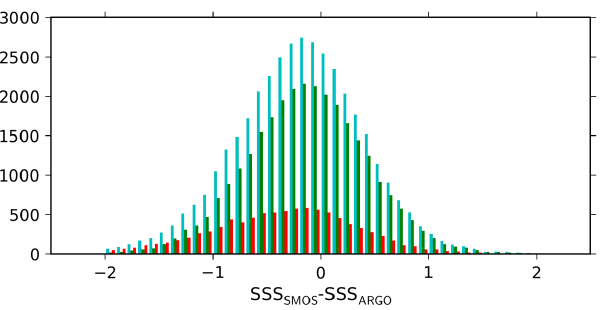
Fig. 6. Statistical distribution of SMOS SSS minus ARGO SSS in the tropical Pacific Ocean for various sortings on SSM/I rain rates; blue: all collocations (without any rain sorting); green: non- rainy cases (SSM/I rain rates less than 0.1mmh − 1 ) ; red: rainy cases (SSM/I rain rates larger than 0.1mmh − 1 ) . Corresponding statistics are indicated in Table 1.